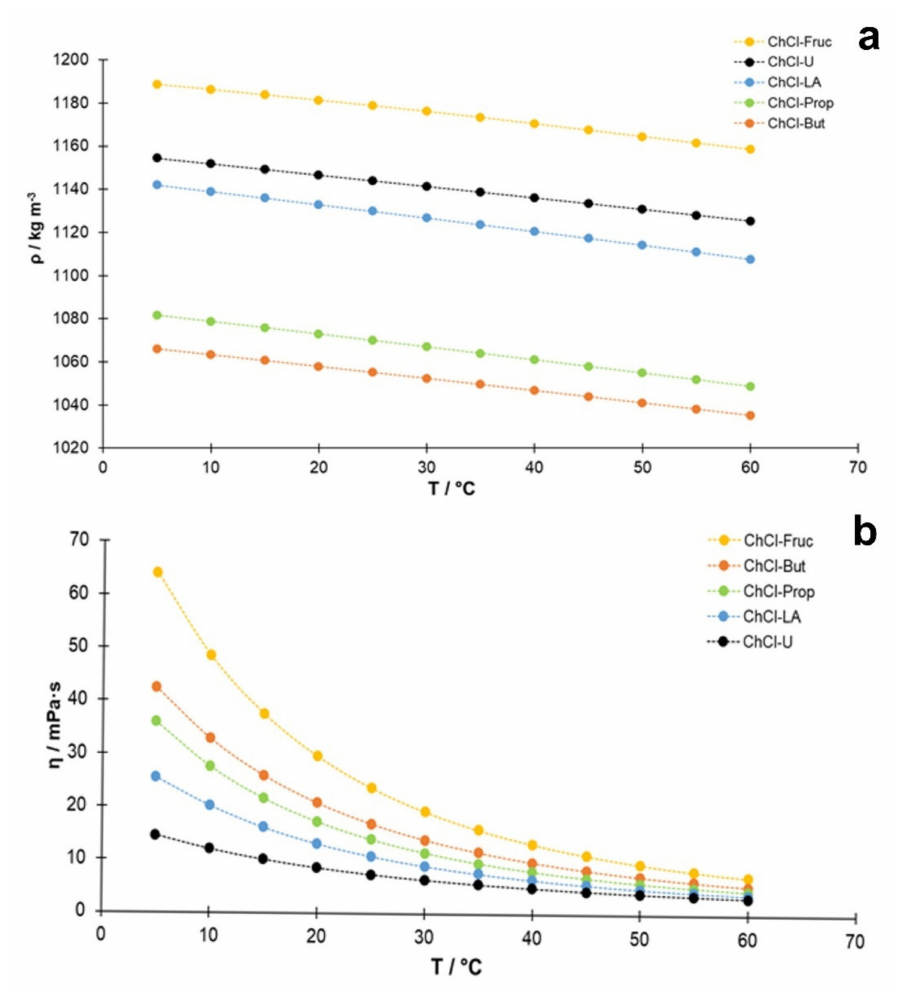
Figure 1. Temperature dependence of experimentally determined ( a ) density ( ρ ; kg m − 3 ) and ( b ) viscosity ( η ; mPa · s) of NADES with 25% ( w / w ) water content. The measured dynamic viscosities, η ( T ), of the prepared NADES in the temperature range between 5 ◦ C and 60 ◦ C in increments of 5 ◦ C are shown graphically in Figure 1b. The lowest viscosity at 50 ◦ C (the temperature used in this study during the extraction process) was determined for ChCl-U (3.87 mPa · s), followed closely by lactic acid-based NADES (ChCl-LA, 4.24 mPa · s), while the highest value was detected for the sugar-based NADES (ChCl-Fruc, 9.50 mPa · s). In the case of polyalcohol-based NADES, a lower value of dynamic viscosity was observed for the ChCl-Prop (5.82 mPa · s) compared to the value of 7.11 mPa · s obtained for ChCl-But. The validity of the viscosity measurements was verified for the case of reline (choline chloride:urea, 1:2) containing 25% ( w : w ) water, and a good consistency was found with the published data (e.g., 7.29 mPa · s against 7.90 mPa · s